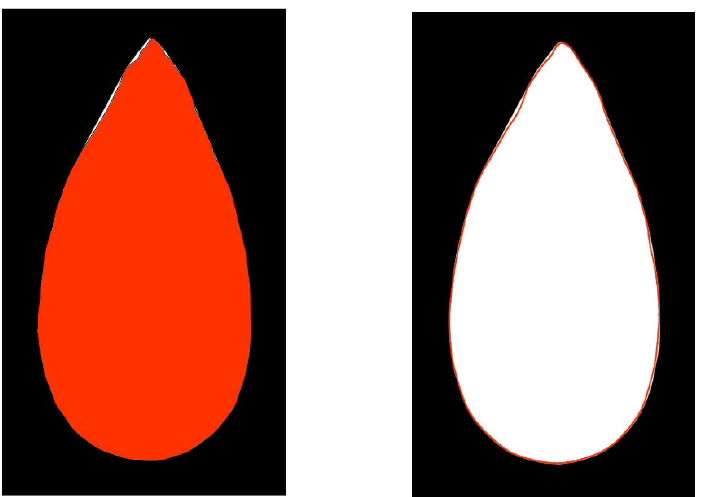
Figure 3. Superposition of the convex Hull with the silhouette image of A. natalia (in red, left ) and with the silhouette obtained with 20 harmonics ( right ). Partial concavities correspond with small white areas between the silhouette and the convex Hull.